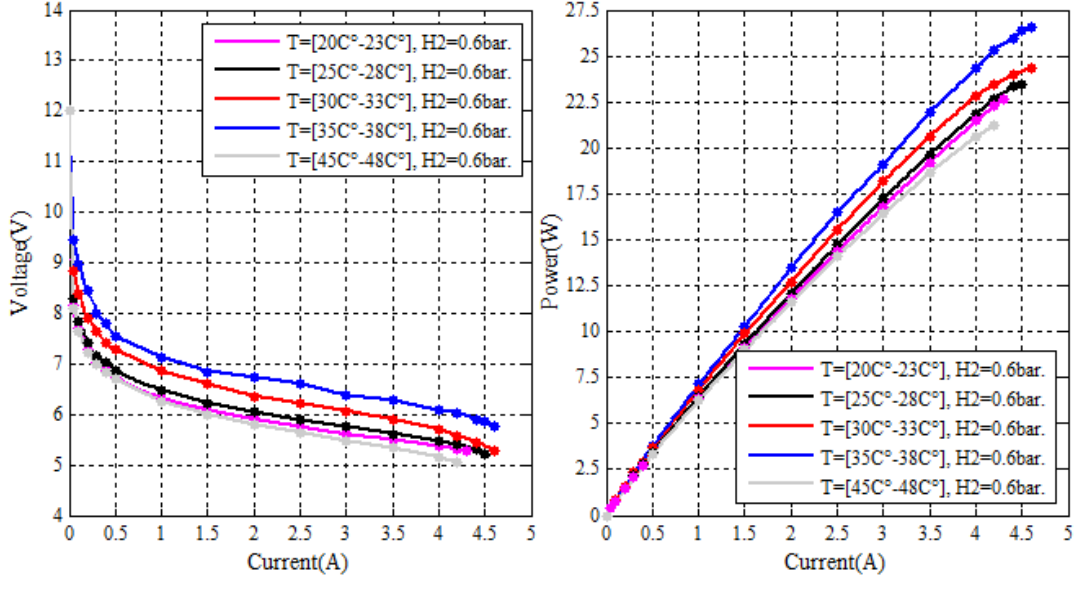
Figure 9. Experimental polarization curves for various operating temperatures (20–48 ◦ C).